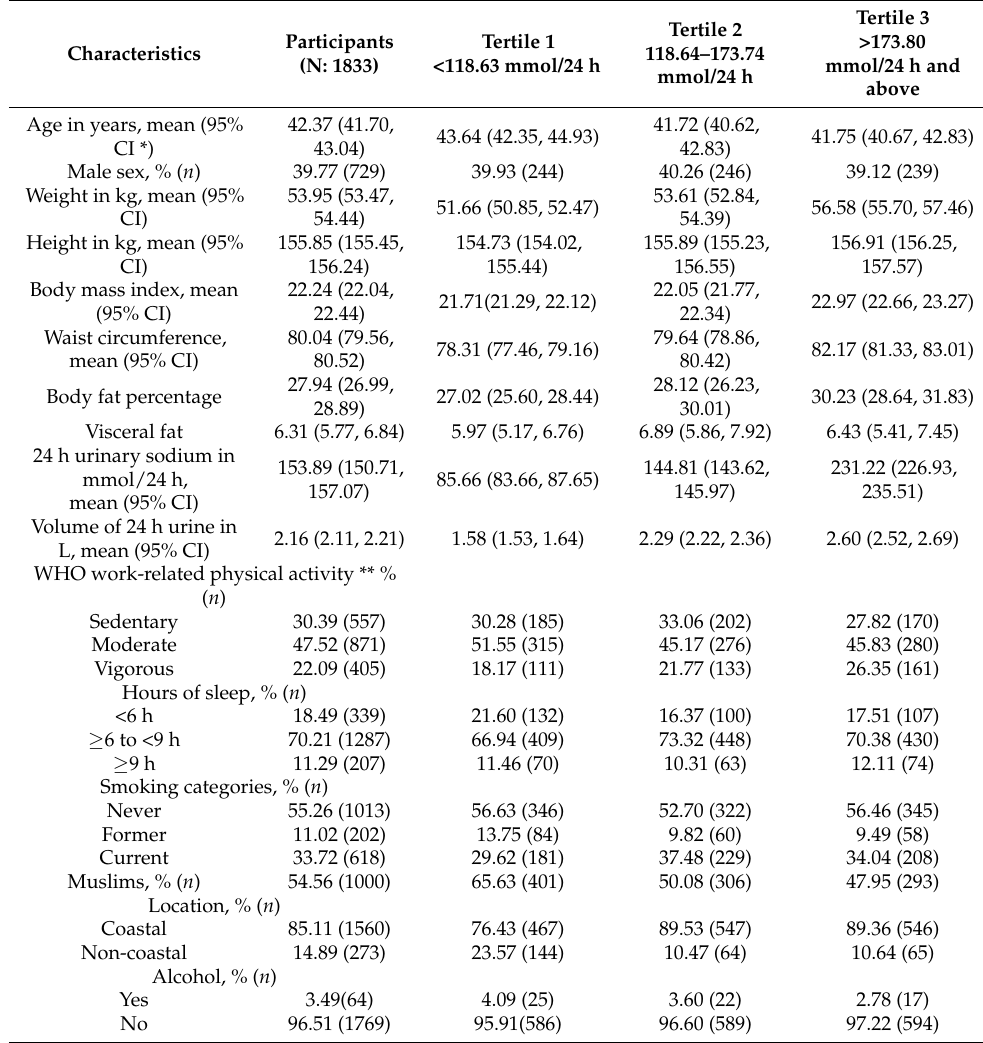
Table 1. Characteristics of